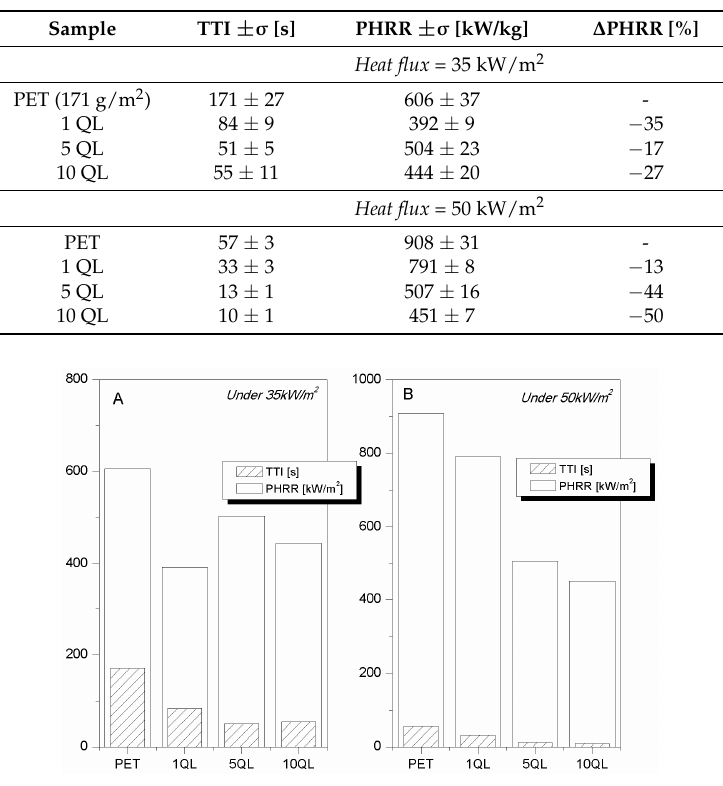
Table 11. Combustion data of untreated and QL-treated PET by cone calorimetry under different heat fluxes [29].